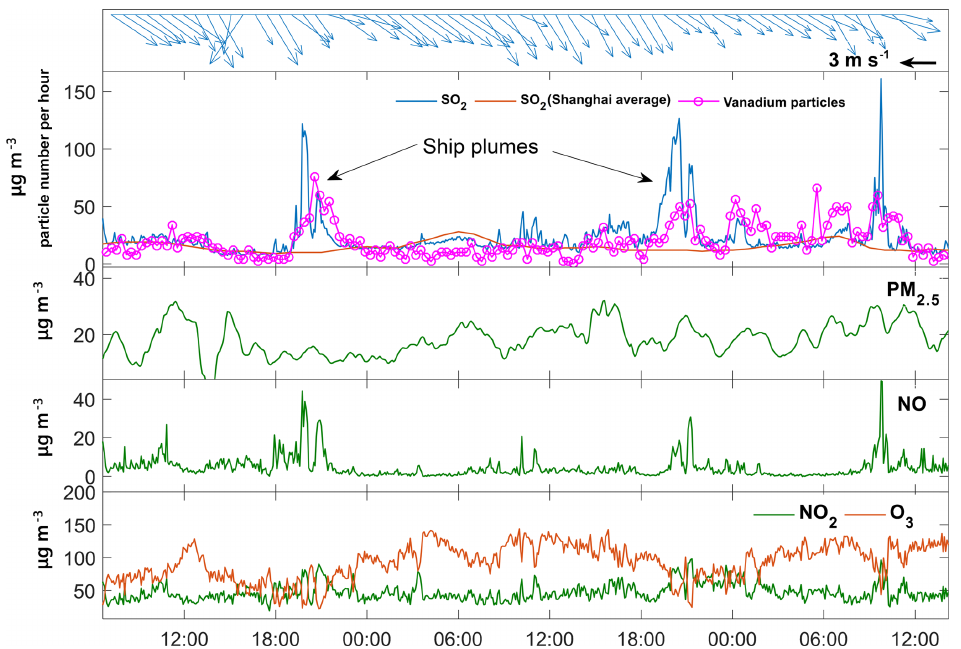
Figure 2. Temporal concentration of pollutants – SO 2 , NO, NO 2 , O 3 and PM 2 . 5 – from 27 to 29 August 2016. The contemporary wind direction and speed and the SO 2 concentration in Shanghai city are provided. The vanadium particle numbers detected by the SPAMS instrument are plotted in the upper panel using the same y axis scale as for SO 2 . Table 1. Results of the statistical analyses of the pollutant concentration levels during the whole sampling period. Numbers are the average concentrations followed by the 25th and 75th quantiles in parentheses. The average pollution levels in Shanghai city during the same period are included for